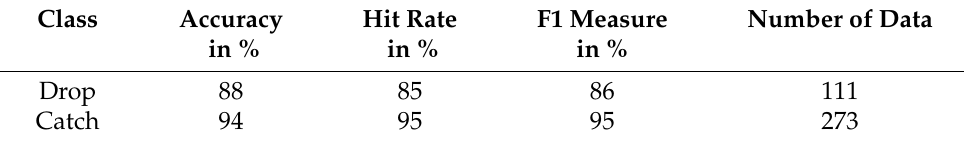
Table 9. Model assessment with the test dataset in audio/video